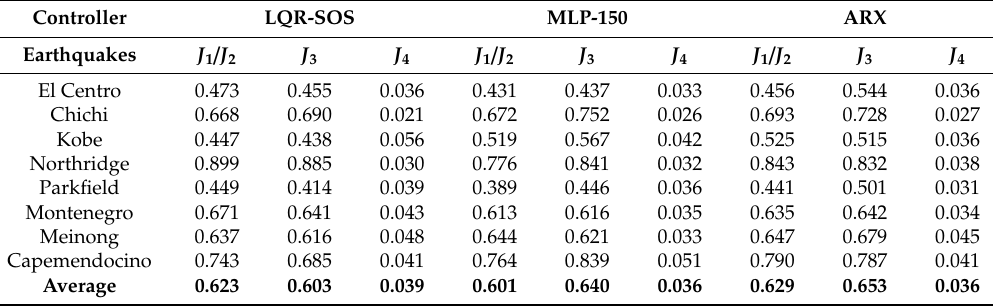
Table 9. Seismic control performance of the experimental validating